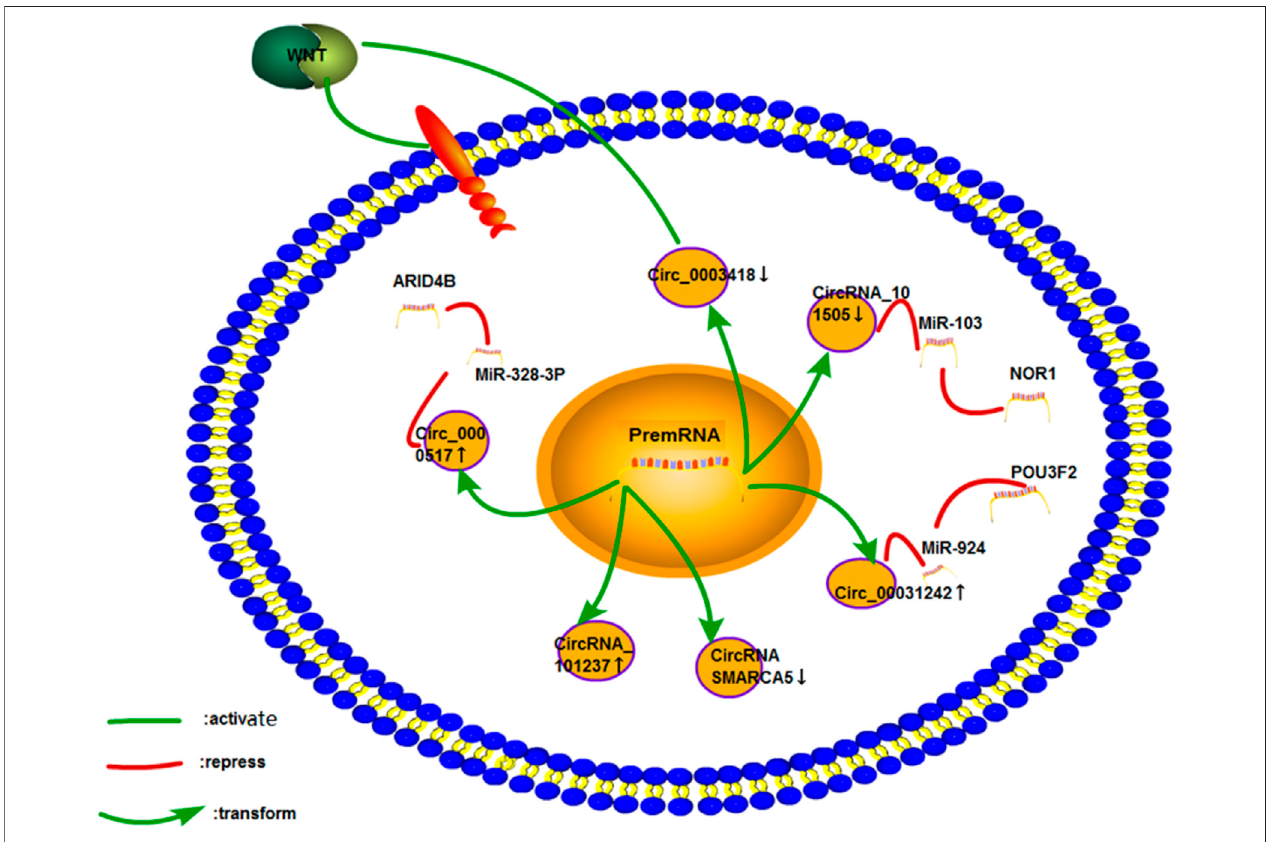
FIGURE12| CisplatinresistancemechanismofcircRNAinlivercancer.Onlysixstudiesonlivercancerhavebeenperformed,andfewstudiesonthemechanismof drug resistance have been conducted. The mechanism of the cisplatin resistance of CircRNA_101237 and CircRNA SMARCA5 has not been studied.